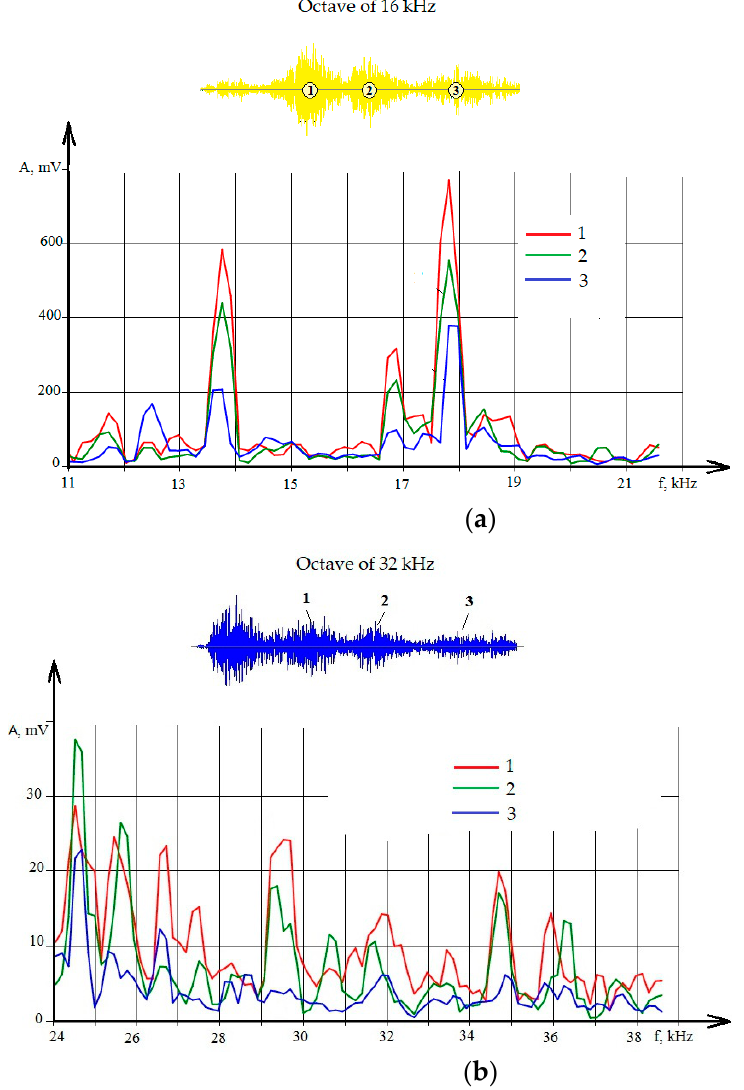
Figure 27. Comparison of the vibroacoustic signal amplitude spectra under pulsed action on a coated plate for different time points corresponding to the VA signals maxima in the octave of 16 kHz ( a ) and 32 kHz ( b ).